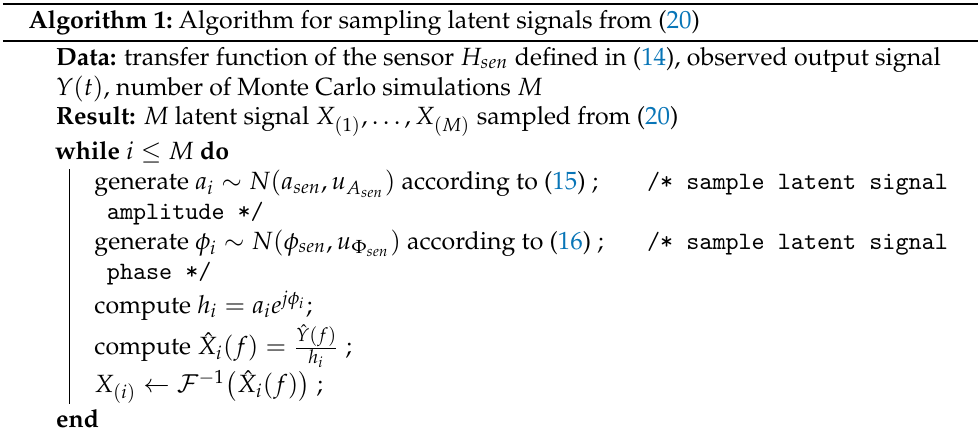
Algorithm 1: Algorithm for sampling latent signals from